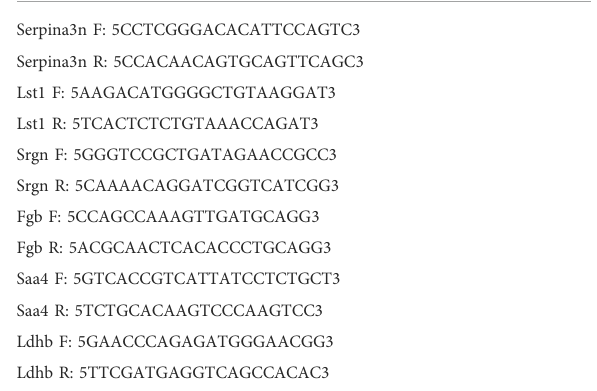
TABLE 2 Sequences of primers used in